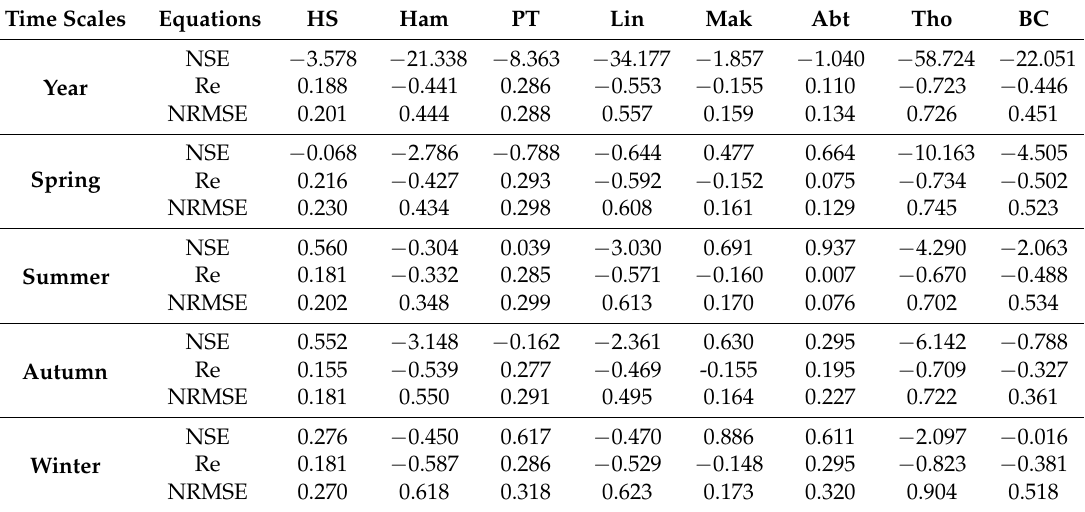
Table 3. Accuracy assessment of PET estimation in Sichuan